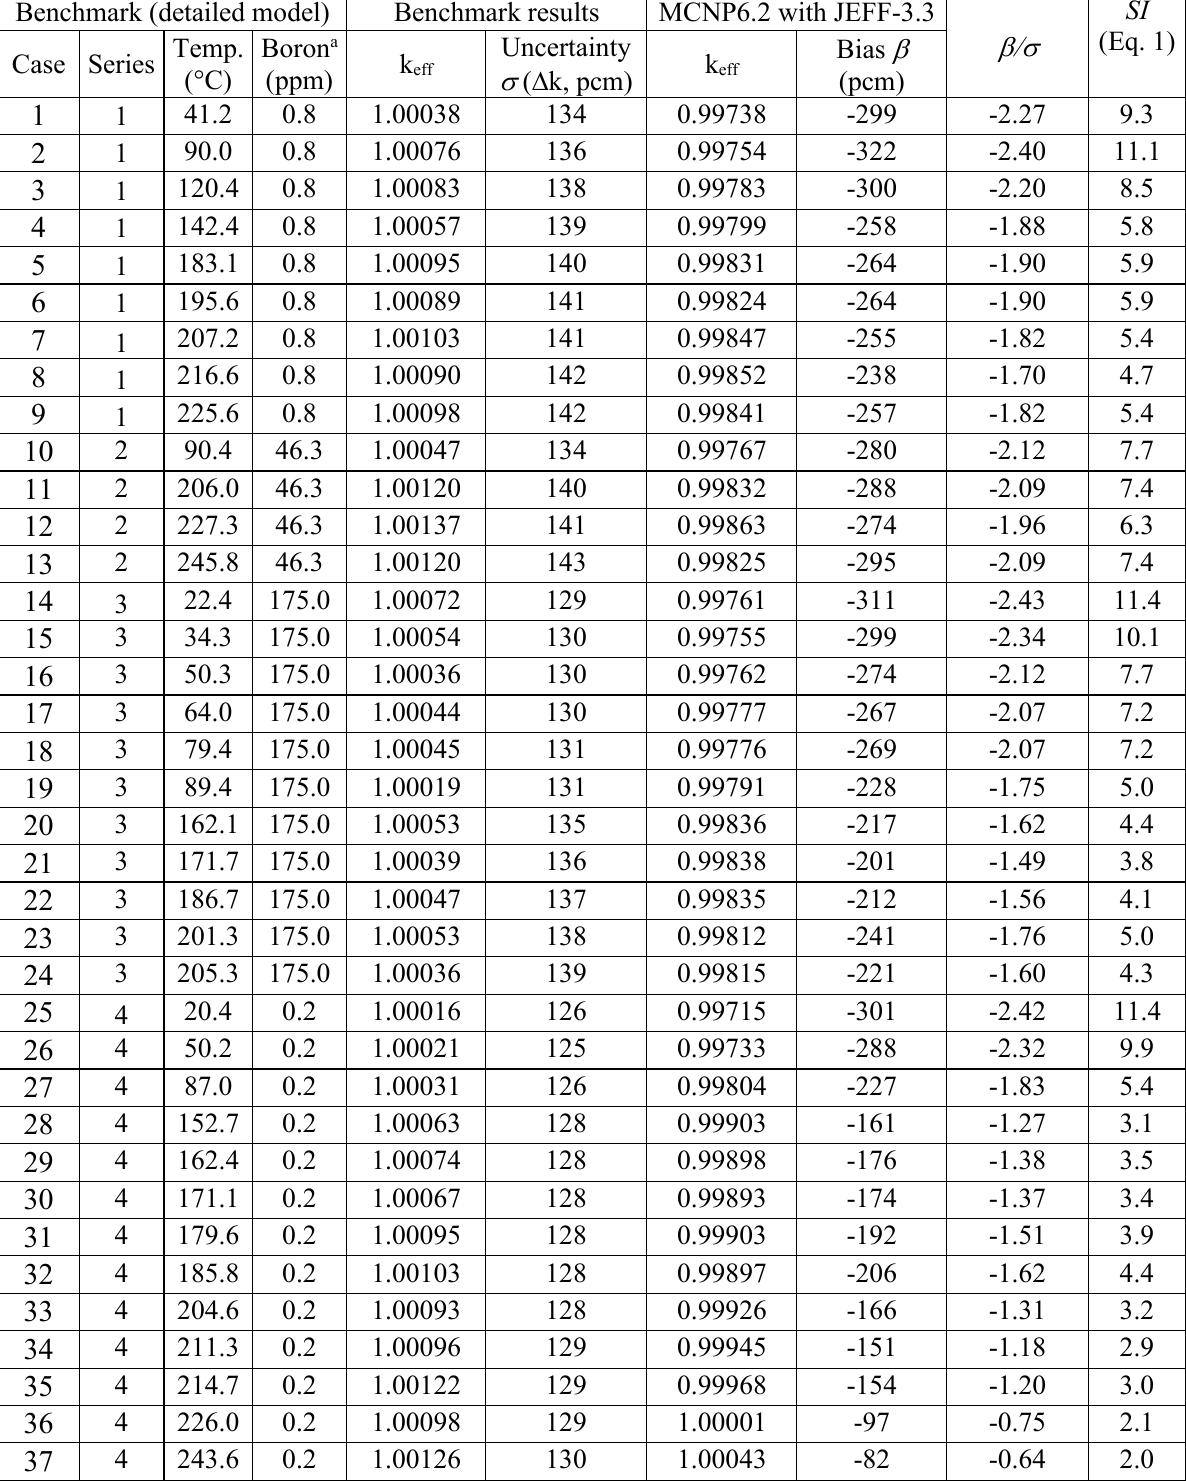
Table I. KRITZ - 1 - Mk Detailed Model Benchmark Cases Using MCNP6.2 and JEFF - 3.3 Benchmark (detailed